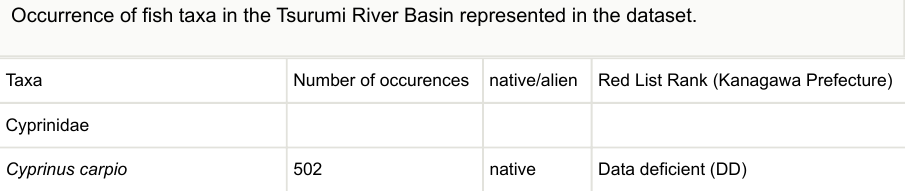
Description: A total of 10 families, 28 species and 9,335 individuals were collected from 71 stations during the summer and winter surveys (Table 1). St. 17 and St. 52 had the highest number of species (12) and St. 54 had the highest number of individuals (679). In contrast, fish were not detected at St. 12, St.19 and St.67. The highest number of individuals found was 2,708 in Zacco platypus , which appeared at 45 stations.